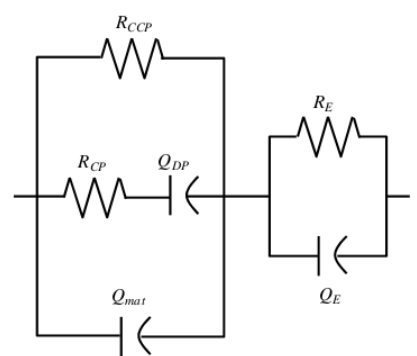
Figure 2: Electrical equivalent microstructural model. Figure 3: Example of EIS results on TiO 2